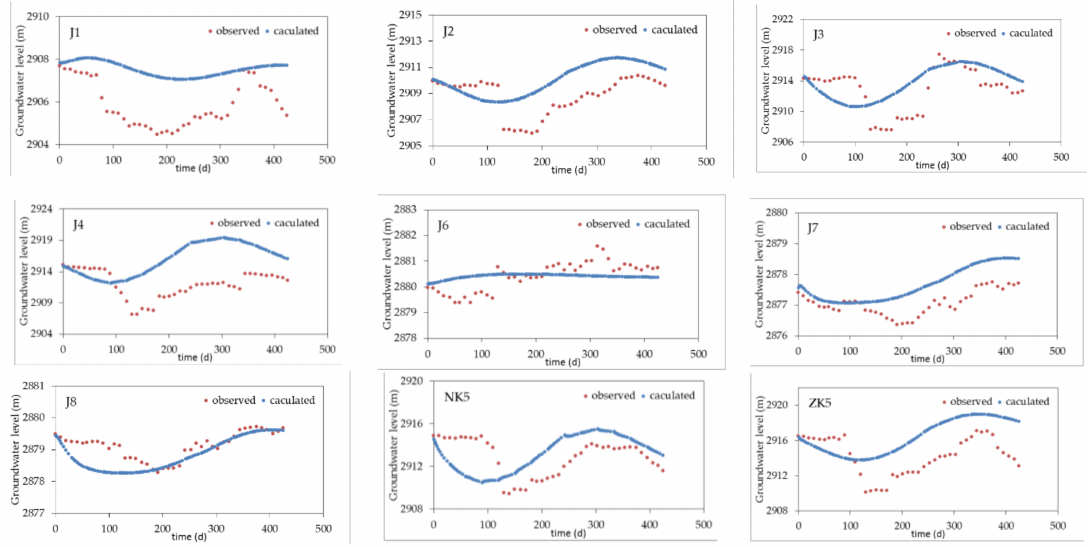
Figure 12. Curves fitted to the groundwater observation wells in the verification